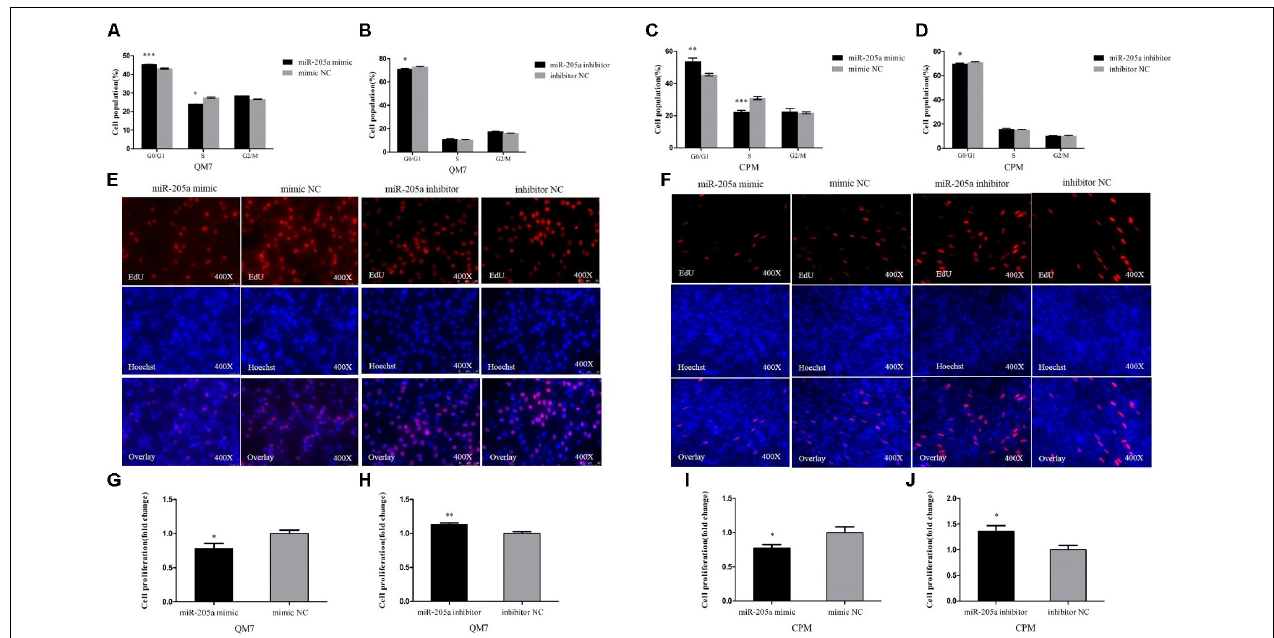
FIGURE 4 | MiR-205a represses the proliferation of myoblast. (A–D) Cell cycle analysis of QM7 and CPM cells 48 h after overexpression and inhibition of miR-205a. (E,F) EdU staining after transfection of miR-205a mimic and miR-205a inhibitor in QM7 and CPM cells. (G–J) The proliferation rate of QM7 and CPM cells transfected with miR-205a mimic and inhibitor. Results are shown as mean ± SEM and the data are representative of at least three independent assays. Independent sample t -test was used to analyze the statistical differences between groups. ∗ P < 0.05; ∗∗ P < 0.01; ∗∗∗ P < 0.001.